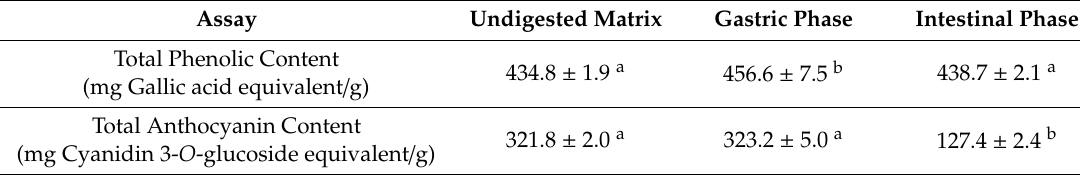
Table 1. Impact of in vitro gastrointestinal digestion on total phenolic and total anthocyanin contents of Vaccinium myrtillus fruit extract. Assay Undigested Matrix Gastric Phase Intestinal